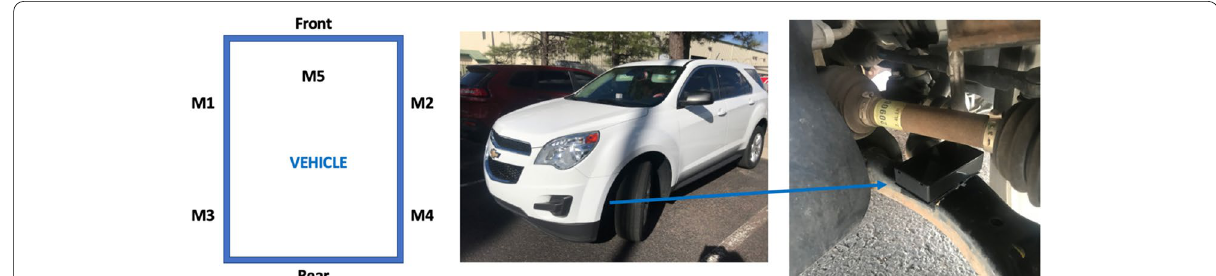
Fig. 2 Sensor placements prior to field data collection. Note: M1 and M2 were placed on the front wheels of the vehicle, M3 and M4 were placed on the rear wheels of the vehicle. The vehicle in the figure is an example to show the sensor placement